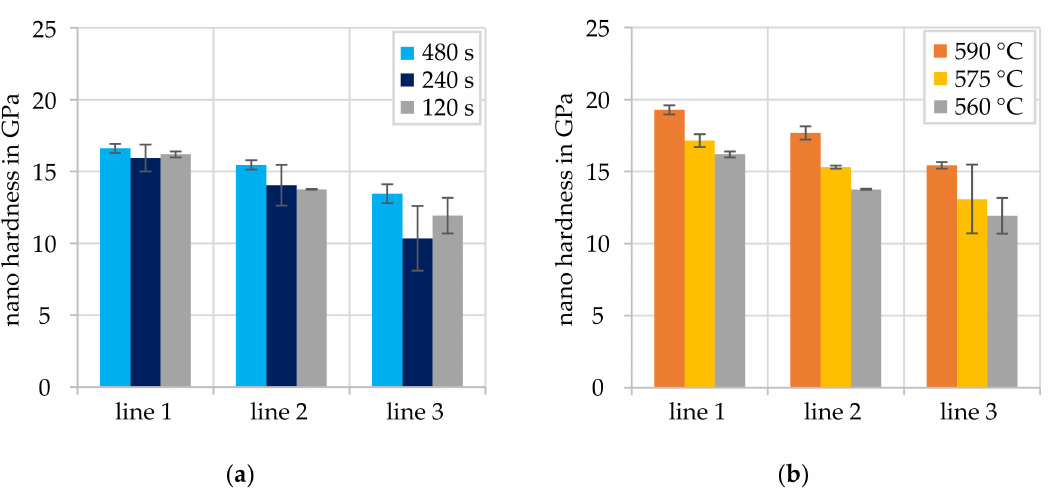
Figure 11. Nano hardness in the joining zone. ( a ) For a forming temperature of 560 ◦ C, a force of 5890 N and di ff erent forming times. ( b ) For a forming time of 120 s, a force of 5890 N and di ff erent forming temperatures.